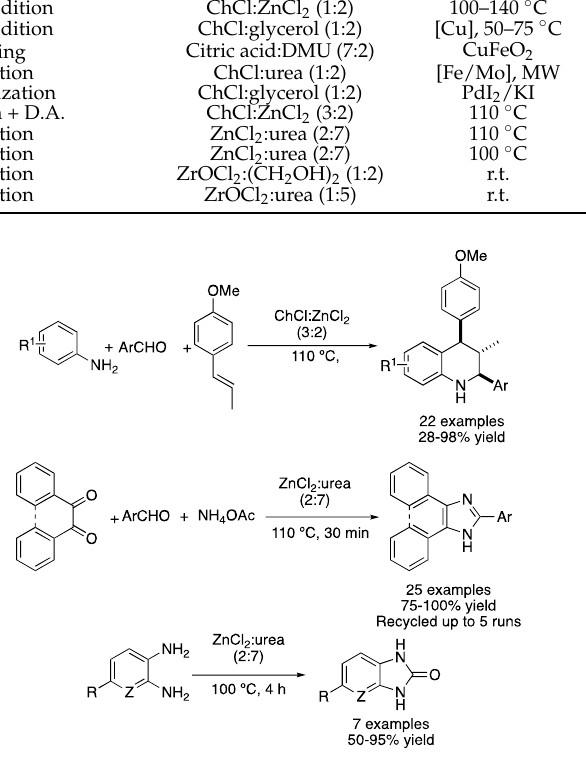
Figure 14. Condensation-based cyclization reactions using Zn-based type I and IV DESs.